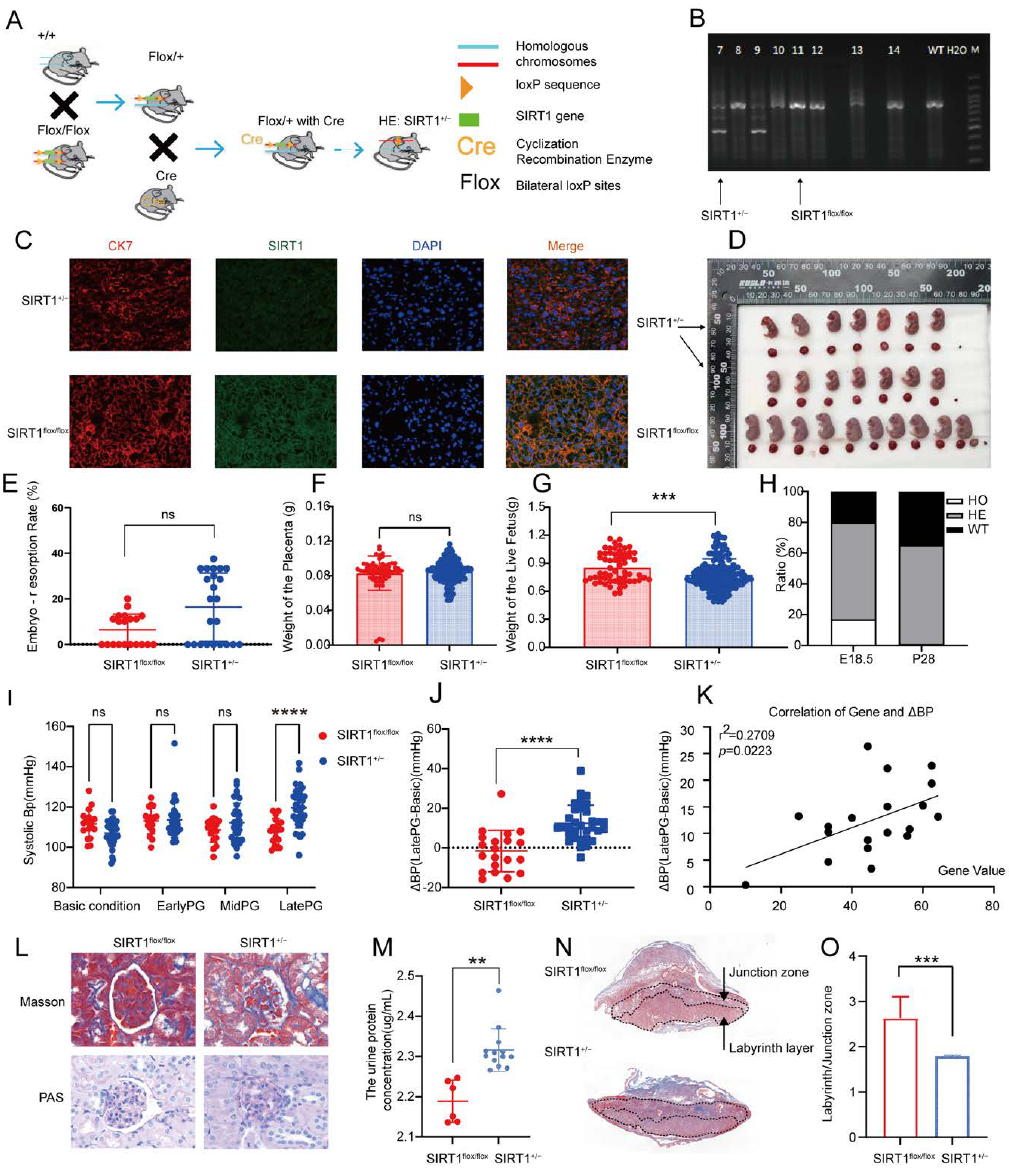
Figure 2. SIRT1 +/ − mice demonstrated pre-eclampsia-like symptoms. ( A ) Schematic diagram of SIRT1 +/ − mice construction. ( B ) Genotype of SIRT1 +/ − mice using PCR and agarose gel electrophore- sis. ( C ) Immuofluorescence for SIRT1 in mice placental tissues from SIRT1 flox/flox ( n = 3) and SIRT1 +/ − ( n = 7) mice. ( D ) Representative appearance of fetuses and placentas from SIRT1 flox/flox and SIRT1 +/ − groups. ( E – G ) The embryo-resorption rate ( E ), the weight of the placenta ( F ), and the weight of the live fetus ( G ) in SIRT1 flox/flox ( n = 19) and SIRT1 +/ − ( n = 31) mice. ( H ) The gene ratio of fetuses at E18.5 and P28 (E18.5: the 18.5th day of gestation, P28: the 28th day in postnatal age). ( I ) The systolic blood pressure (SBP) at basic condition, early PG (pregnancy), mid PG, late PG from SIRT1 flox/flox ( n = 20), and SIRT1 +/ − ( n = 33) groups. ( J ) ∆ BP (late PG—basic condition) in SIRT1 flox/flox ( n = 20) and SIRT1 +/ − ( n = 33) groups. ( K ) The correlation of ∆ BP and SIRT1 gene values in fetuses. ( L ) Mas- son staining and PAS staining of mice kidney tissues from SIRT1 flox/flox ( n = 3) and SIRT1 +/ − ( n = 7) groups. ( M ) The concentration of urinary protein in SIRT1 flox/flox ( n = 6) and SIRT1 +/ − ( n = 13) groups at late PG. ( N ) Masson staining of mice placental tissues in SIRT1 flox/flox ( n = 3) and SIRT1 +/ − ( n = 7) groups. ( O ) The labyrinth/junctional zone ratio of each group. Error bars, mean ± SD. The data were analyzed by one-way ANOVA (and nonparametric or mixed) and unpaired Student’s test (and nonparametric tests). ** p < 0.01; *** p < 0.001; **** p < 0.0001, ns: no